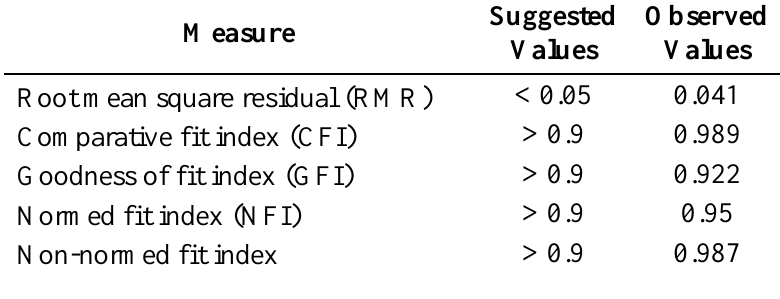
Model Evaluation and Overall Fit